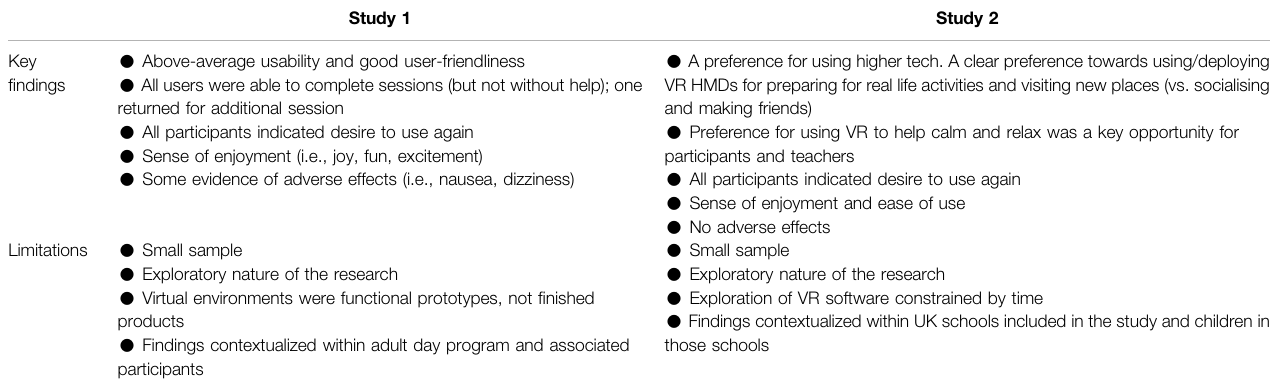
TABLE 3 | Outcomes of Phase 1: Results from analysis of studies (key fi ndings and